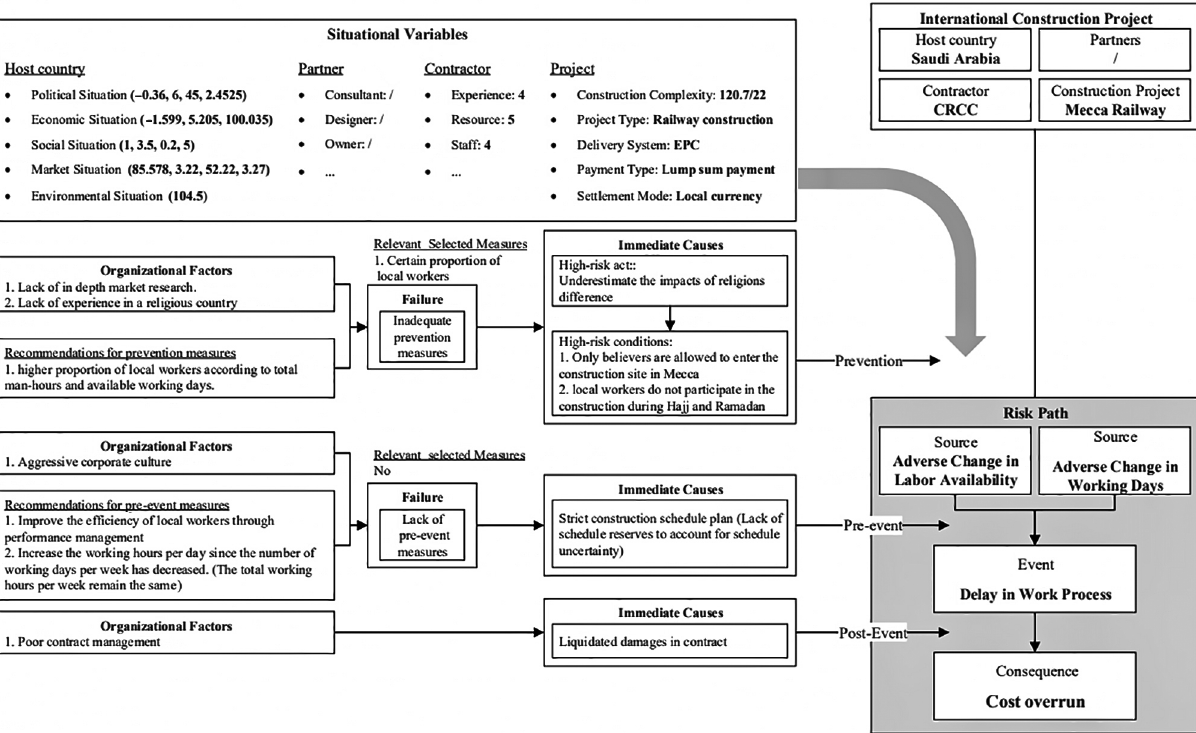
Figure 4. Application of the